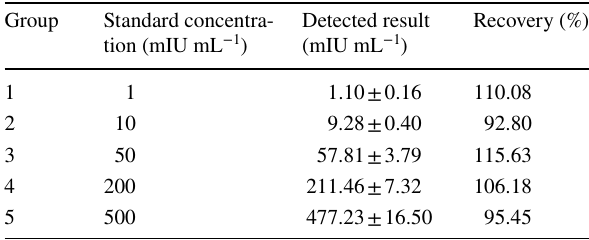
Table 3 Accuracy of the system at different concentrations Group